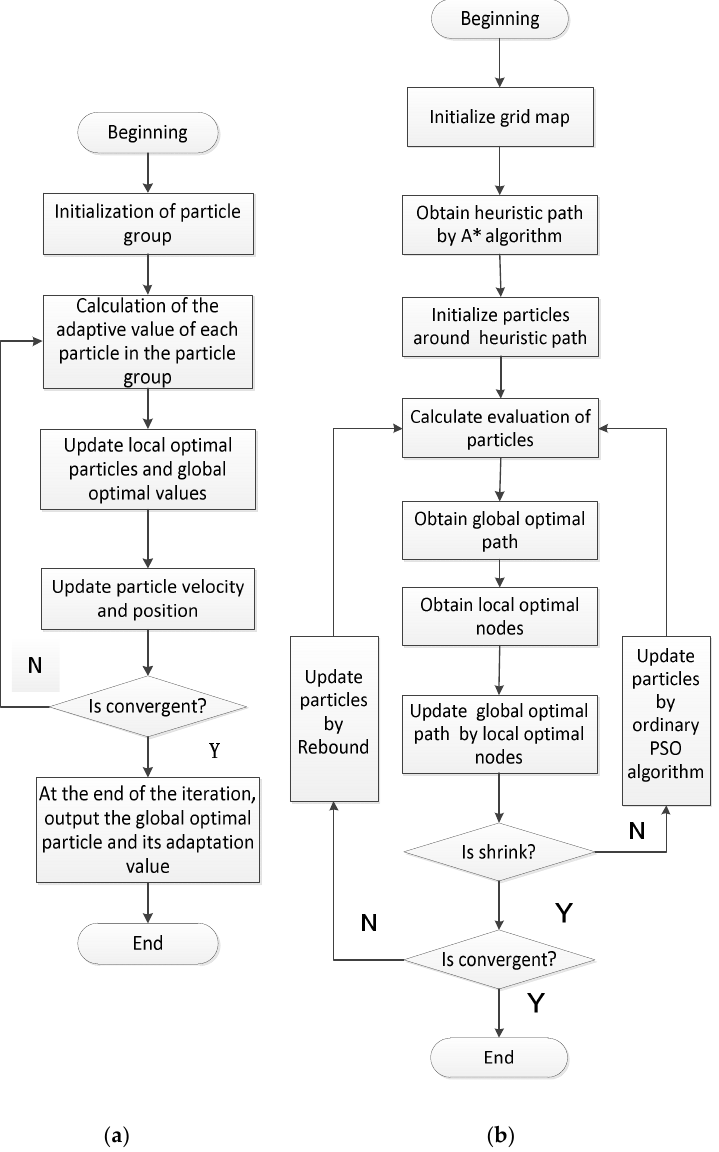
Figure 1. Flowcharts of algorithms. ( a ) Flowchart of ordinary PSO algorithm; ( b ) Flowchart of HEPSO algorithm.